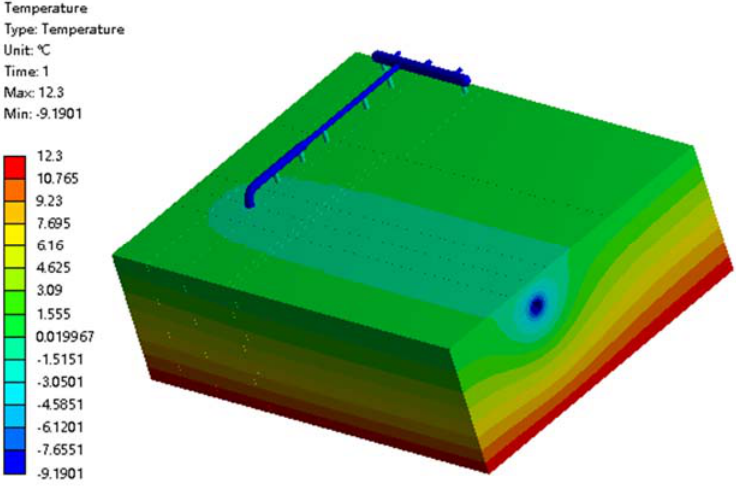
Figure 6. Cloud map of temperature field in the buried pipeline and the surrounding soil.